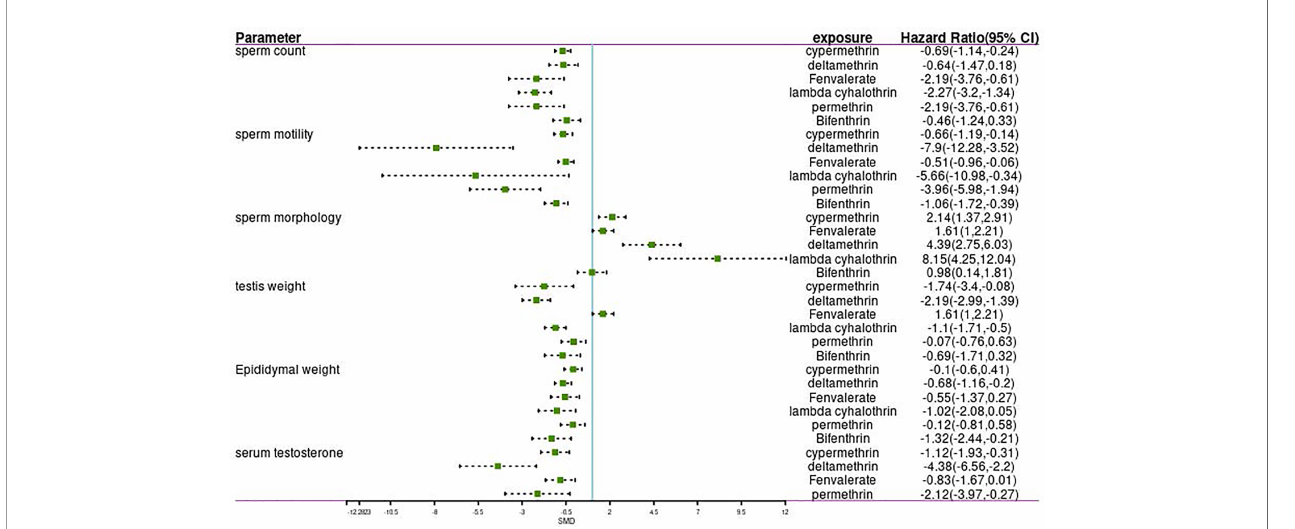
FIGURE 3 | Forest plot showing the effect of pyrethroid exposure on